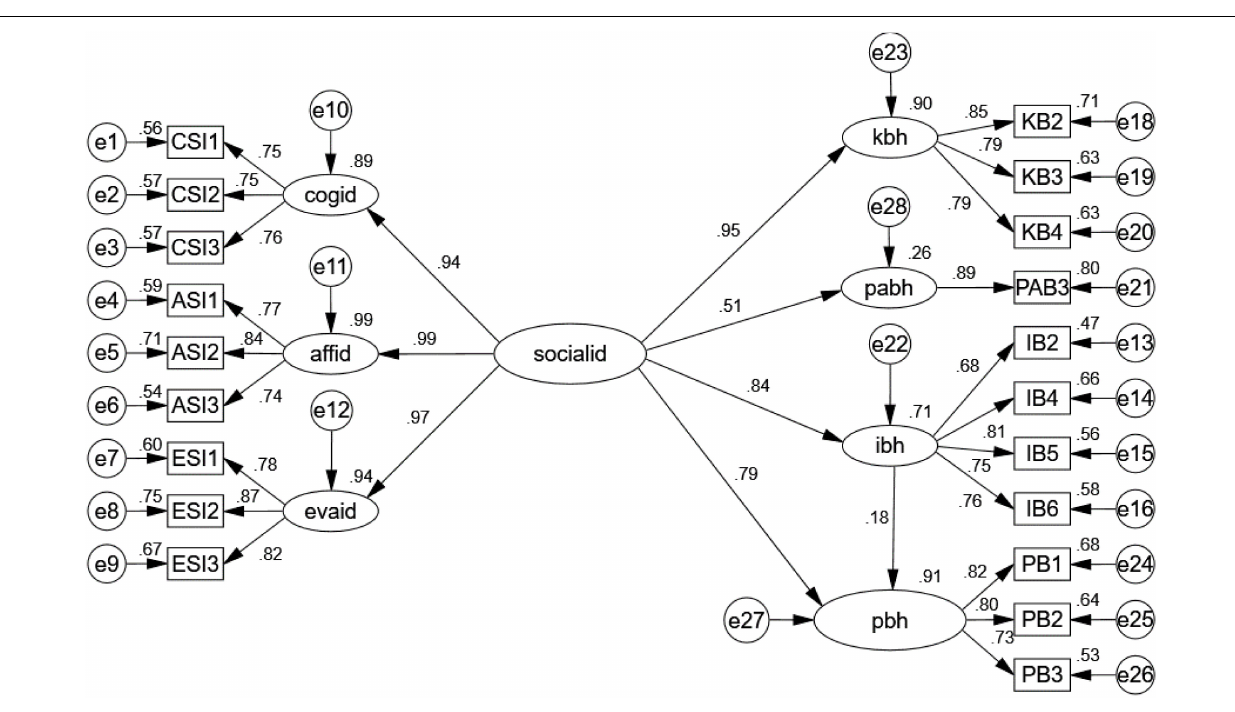
FIGURE 4 | Results of the structural equation model with the male sample. χ 2 = 331.564, df = 163, normed χ 2 = 2.034, goodness of fit index (GFI) = 0.864, AGFI = 0.825, comparative fit index (CFI) = 0.941, standardized root mean square residual (SRMR) = 0.0476, root mean square error of approximation (RMSEA) =